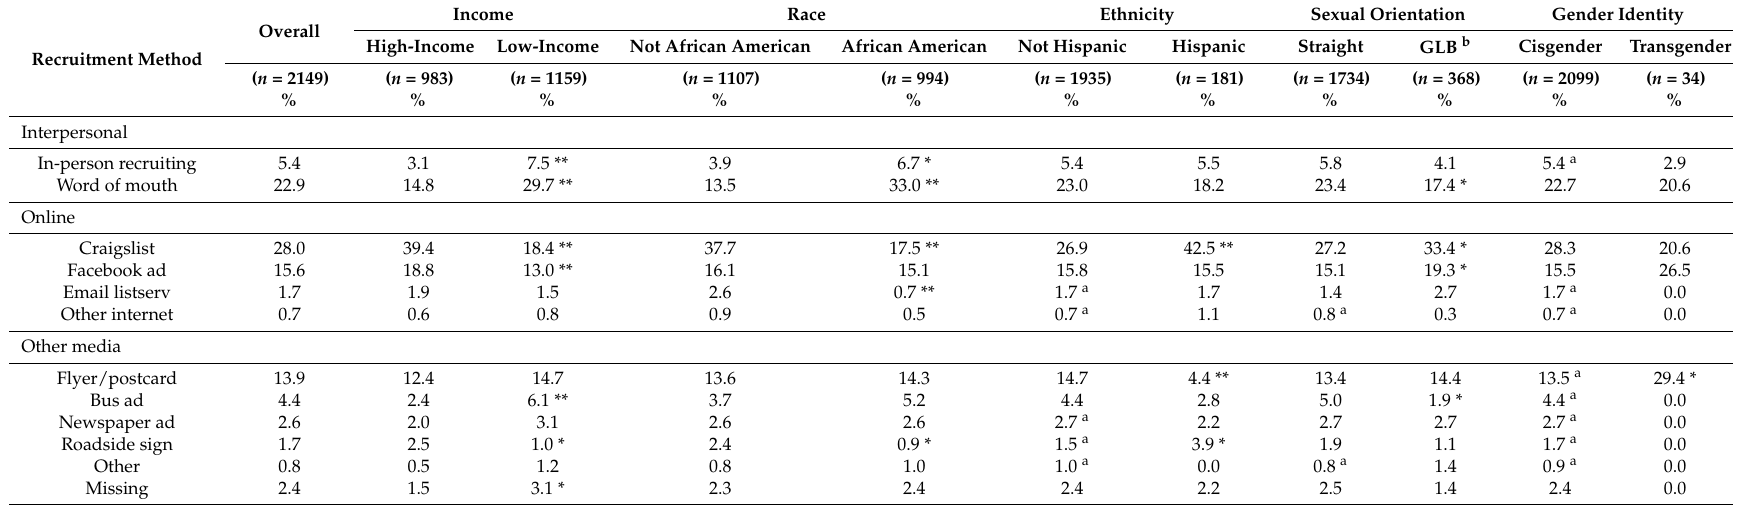
Table 3. Yield of Priority Demographic Groups for Recruitment